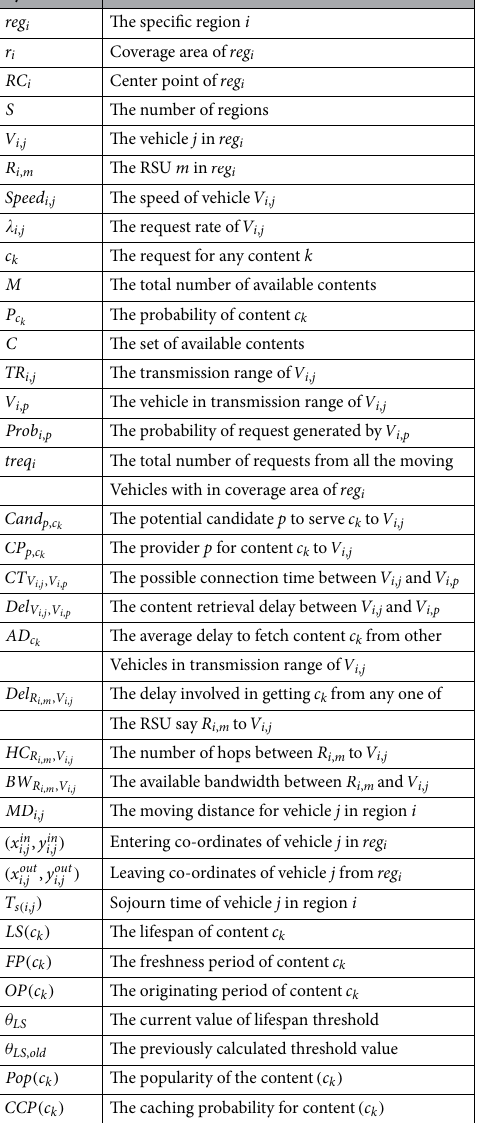
Table 2. Notations and